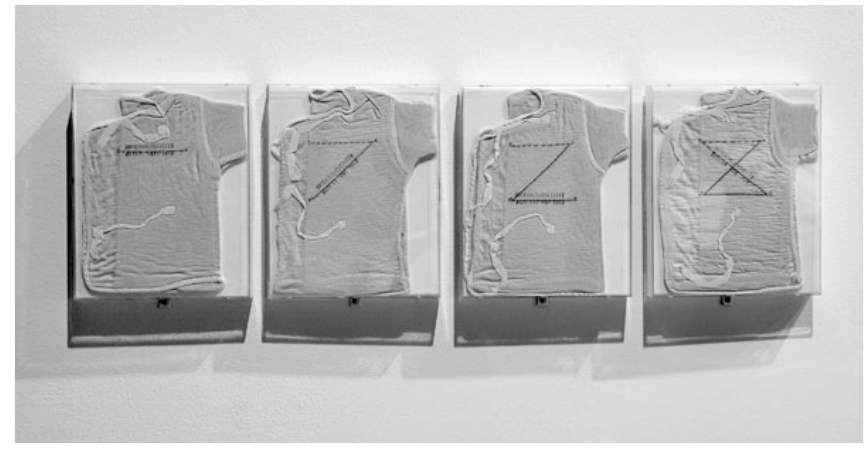
Figure 6: Mary Kelly Post-partum Document Introduction Folded Vests, 1973. Four units 8 x 10 ins. mixed